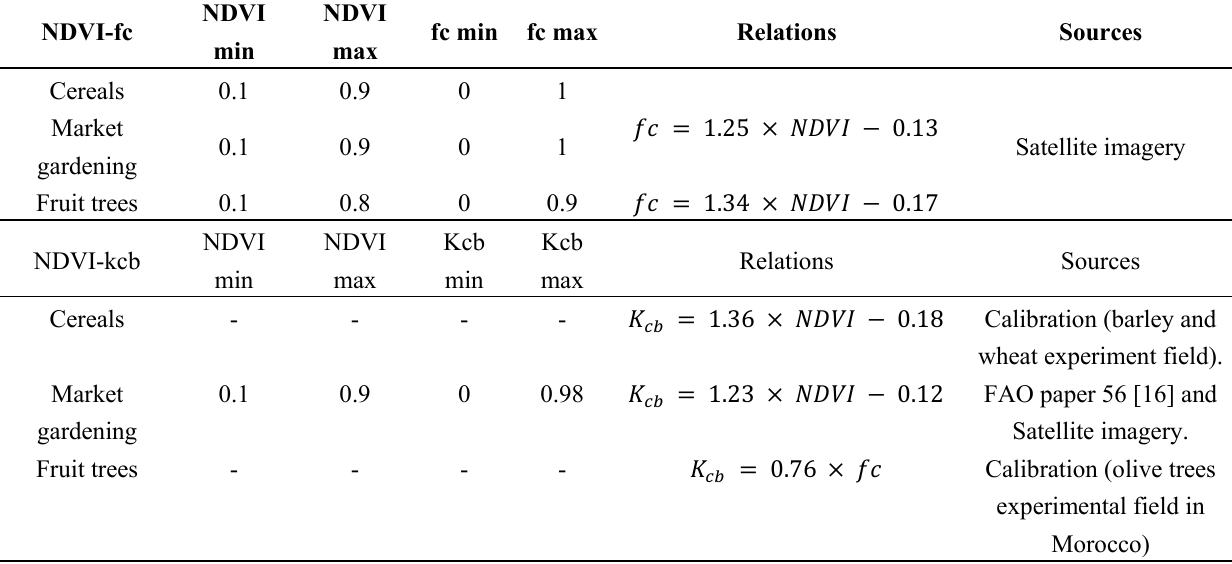
Table 2. Relations used for fc and Kcb estimates from